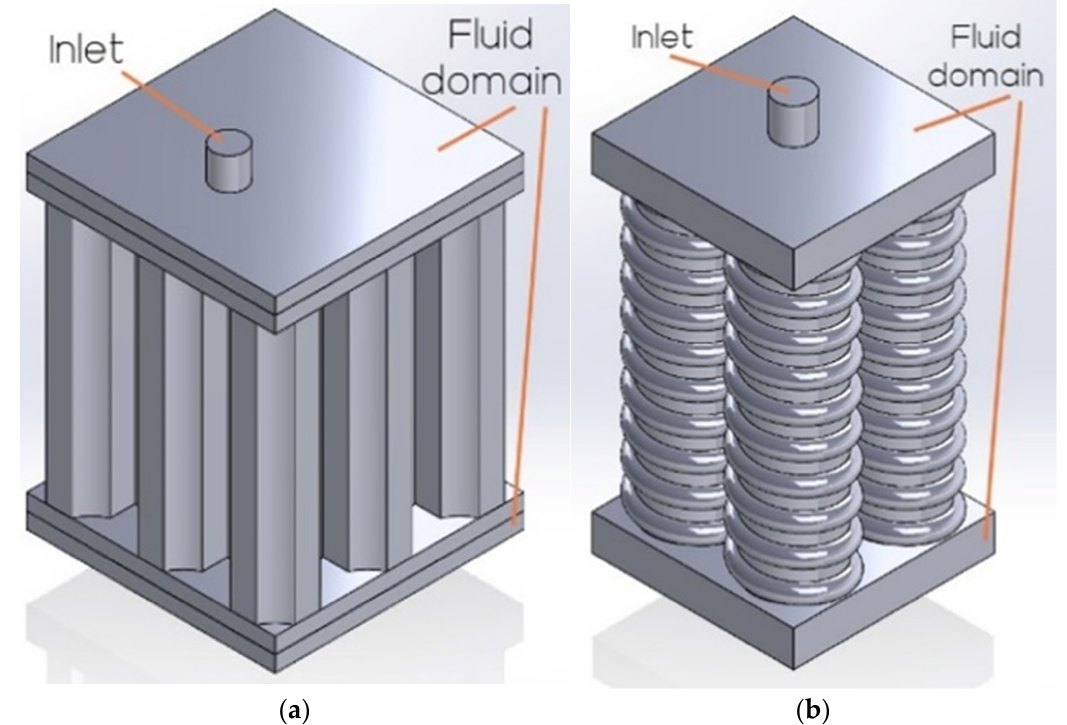
Figure 18. ISO views for the final optimised battery packs: ( a ) LCD; ( b ) HCD.